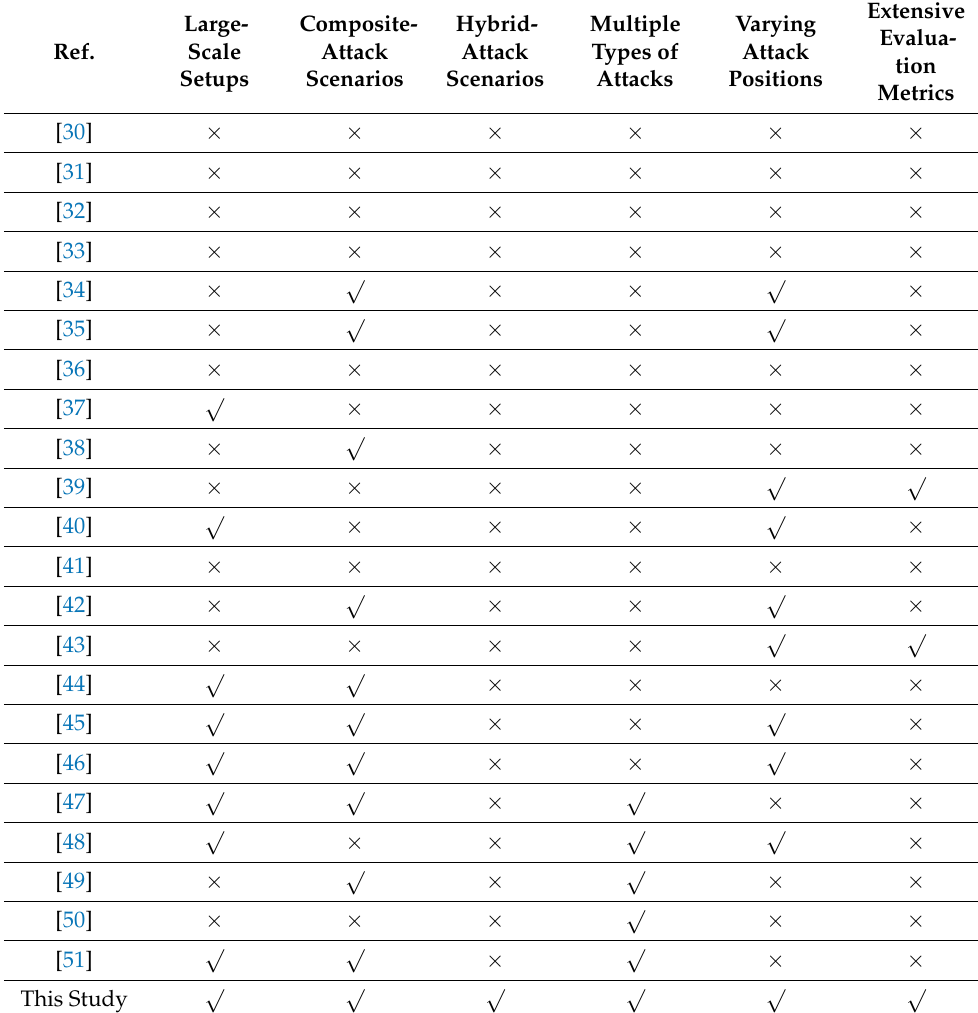
Table 1. Comparison of related work and the current study.